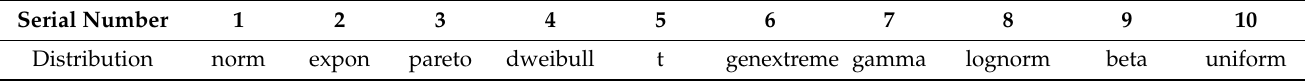
Table 2. Selected distribution